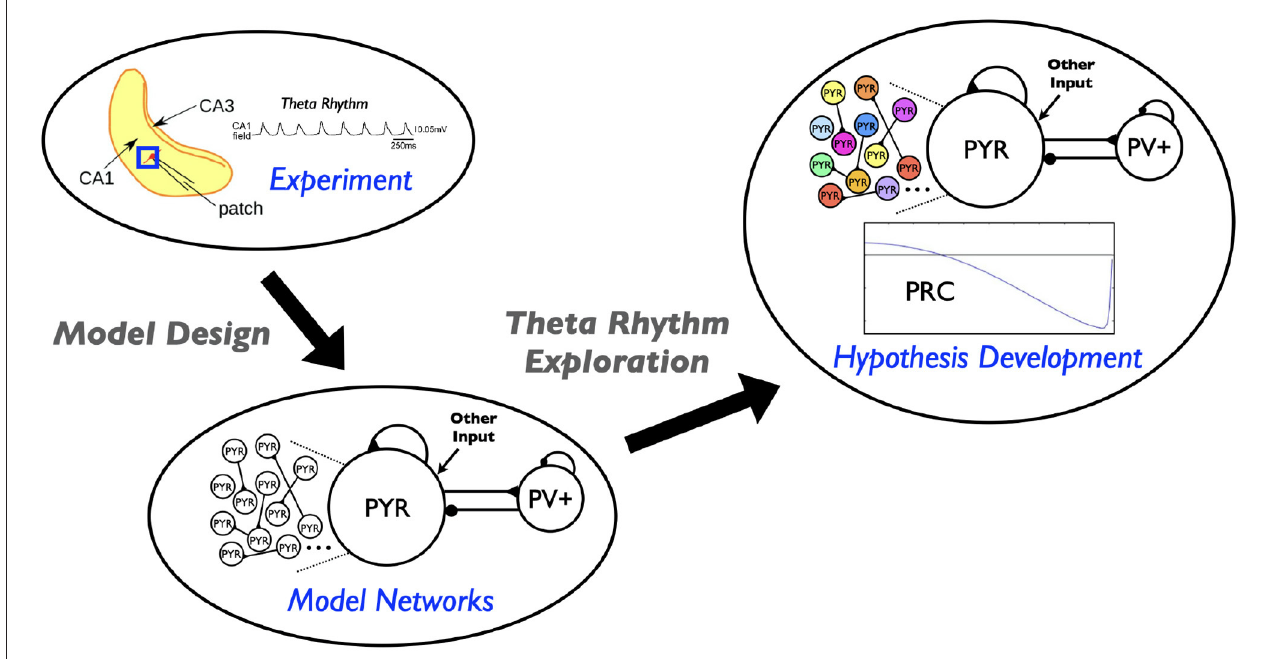
FIGURE 1 | Schematic showing aspects involved in the hypothesis developed in this study. Theta rhythms are generated intrinsically in a whole hippocampus preparation of Goutagny et al. (2009) (“Experiment”). Their generation is captured in a microcircuit model design by Ferguson et al. (2017) (“Model Networks”). In the present paper we assess the robustness of this model design and develop a hypothesis for theta frequency control (“Hypothesis